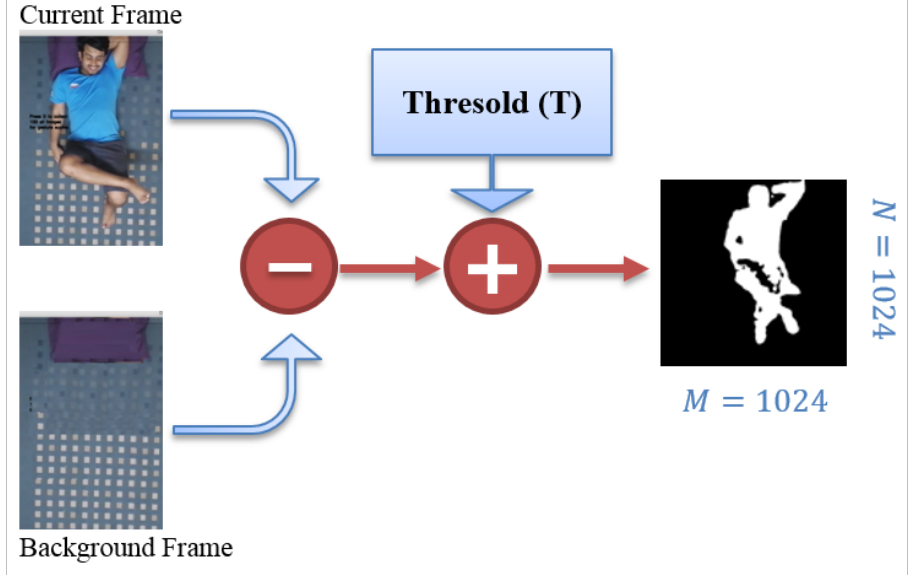
Figure 4. An abstract of background modeling for collecting data posture recognition